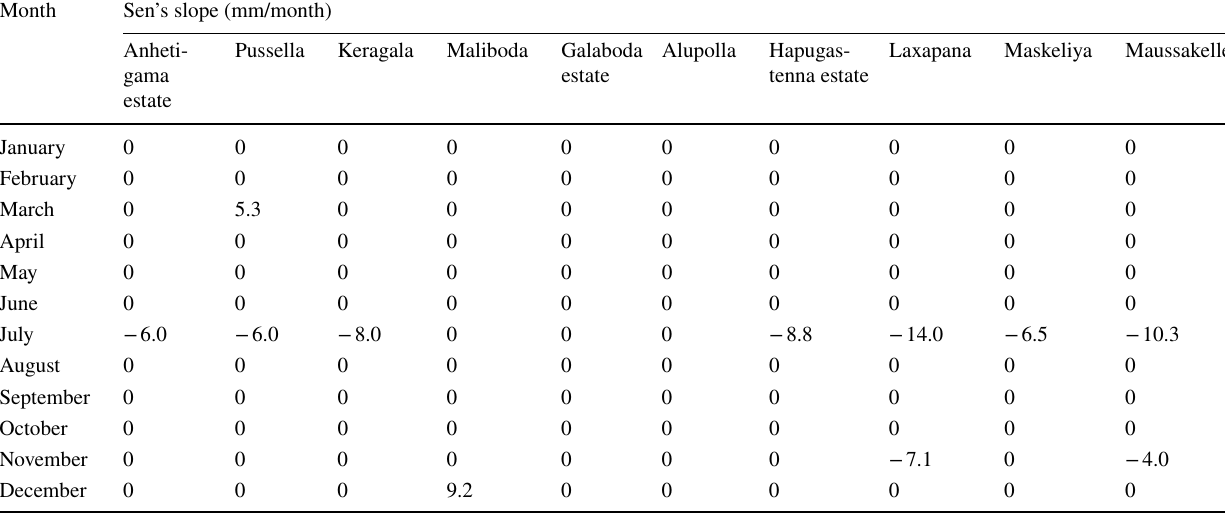
Fig. 4 Hydropower generation of Erathna over the